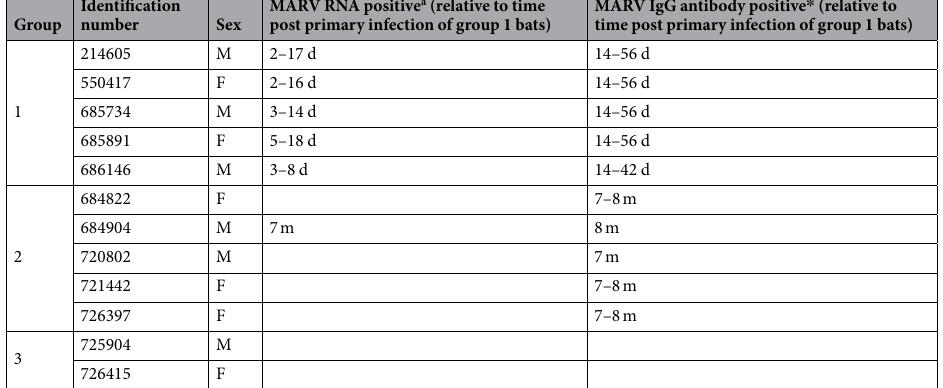
Table 1. Details of the bats according to group. a Blood, oral, rectal and/or urine specimens. * Group 2 bats seroconverted at the indicated time due to exposure to group 1